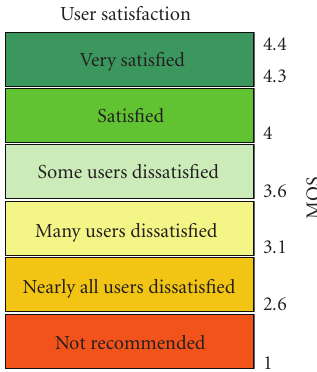
Figure 1: Relation between MOS and user satisfaction